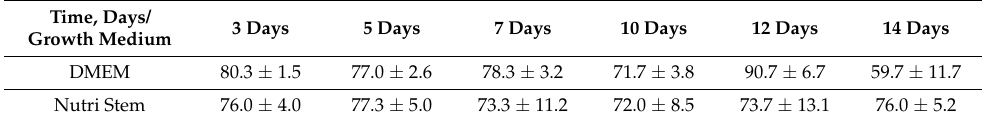
Table 1. Viability of mesenchymal stem/stromal cells during long-term conditioning in two basal media. The data from three independent experiments have been presented as means ± SD.